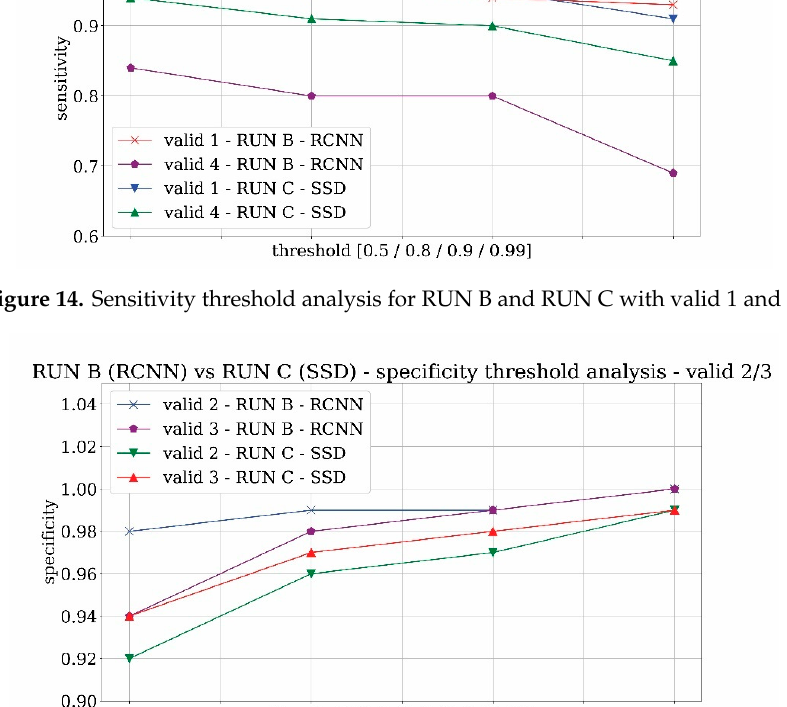
Figure 15. Specificity threshold analysis for RUN B and RUN C with valid 2 and 3.